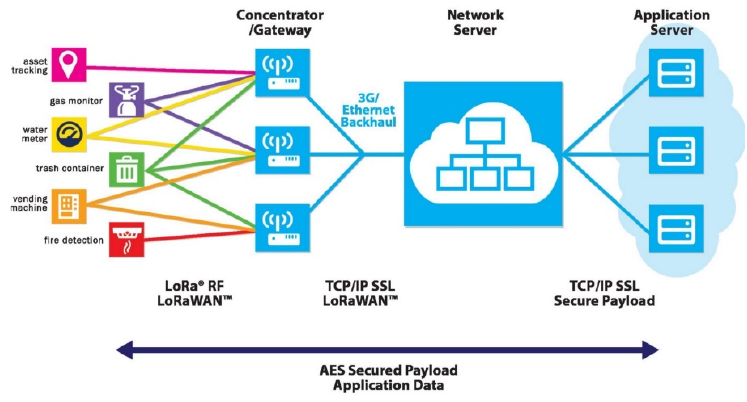
Figure 13. LoRa transmission module.